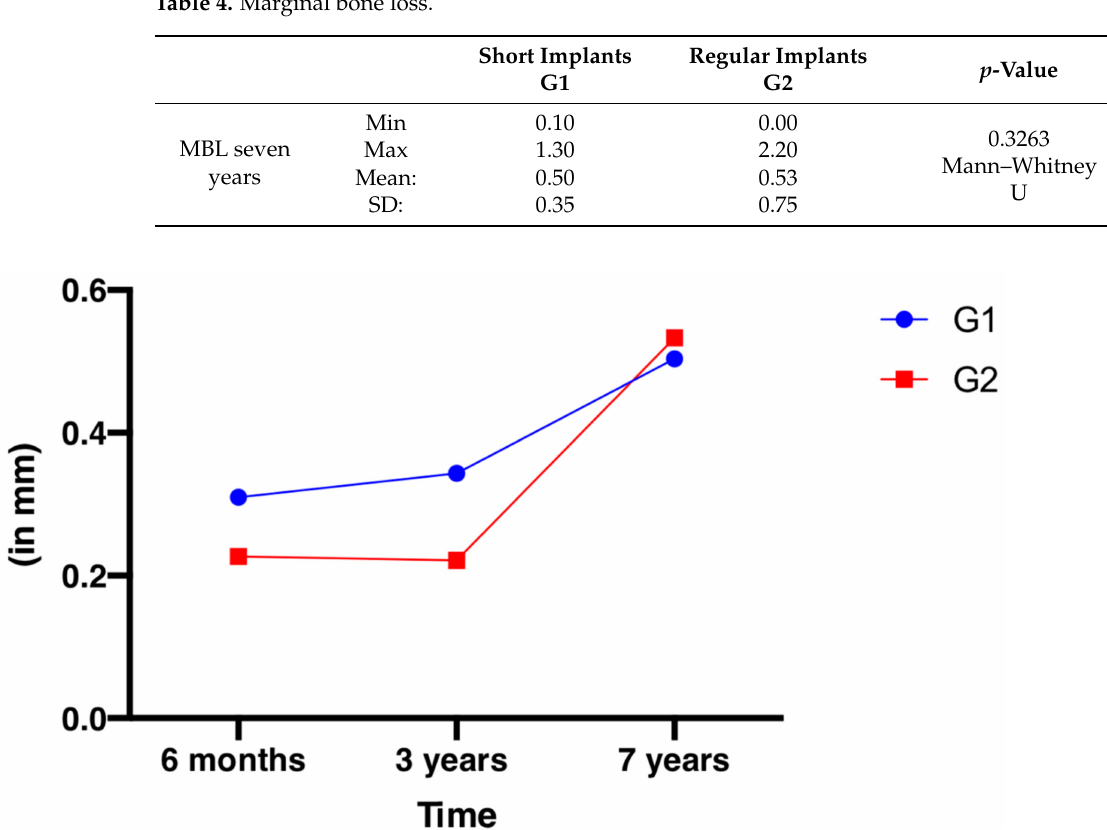
Table 4. Marginal bone loss.